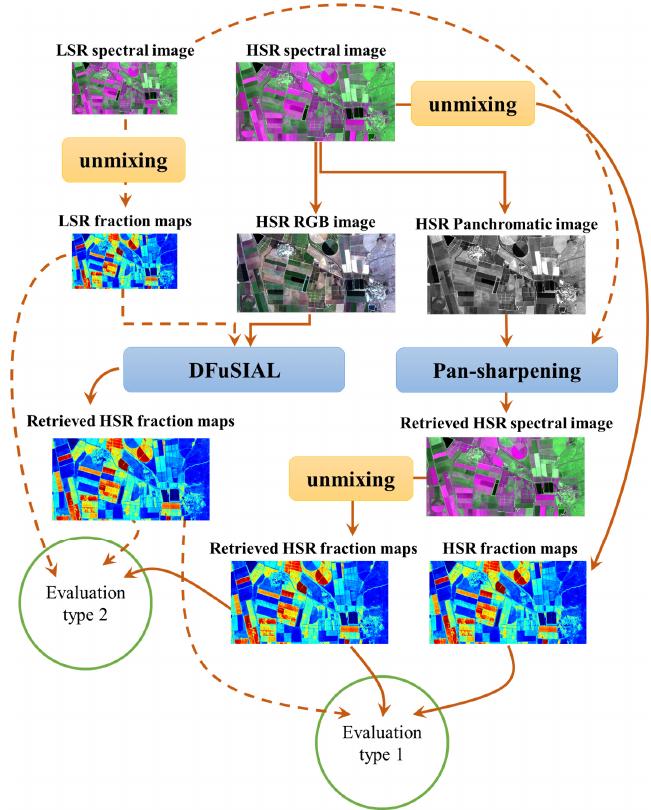
Figure 10. Overview of comparative experimental testing.